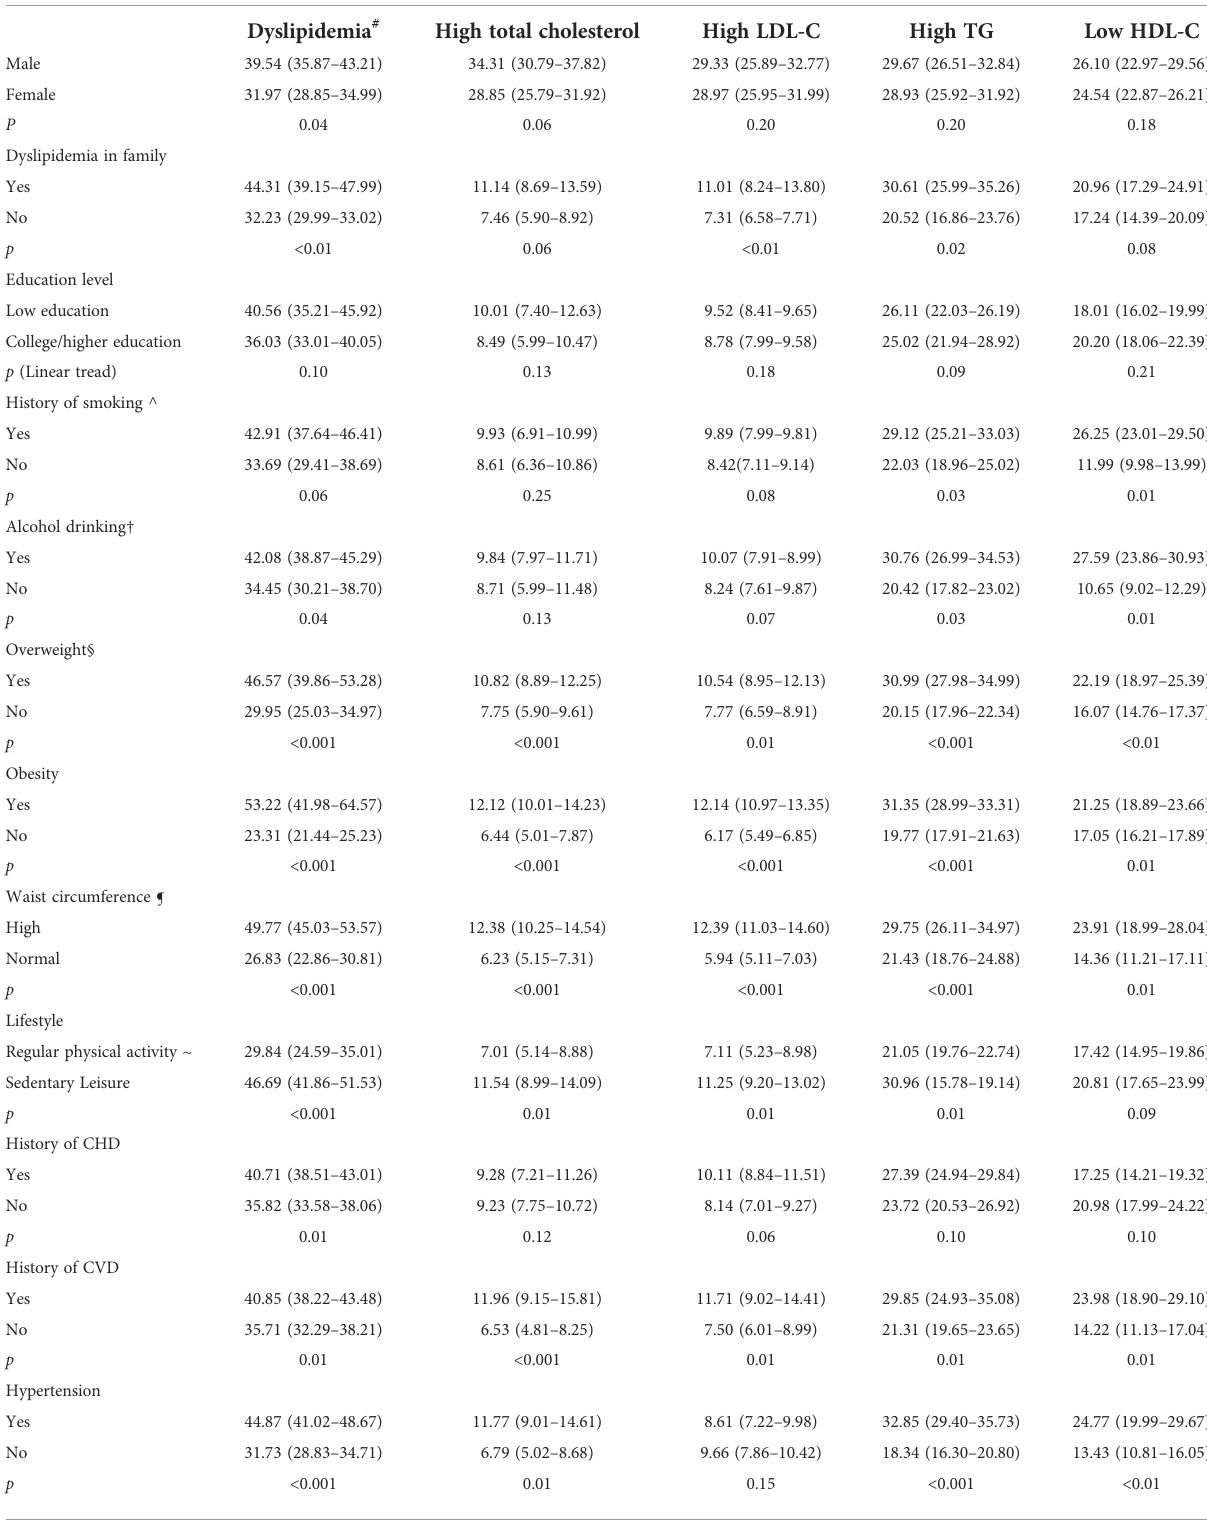
TABLE 4 Mean prevalence of dyslipidemias according to demographic and socioeconomic variables and familial history among adults in East Coast, Fujian, China. Prevalence, * % (95%